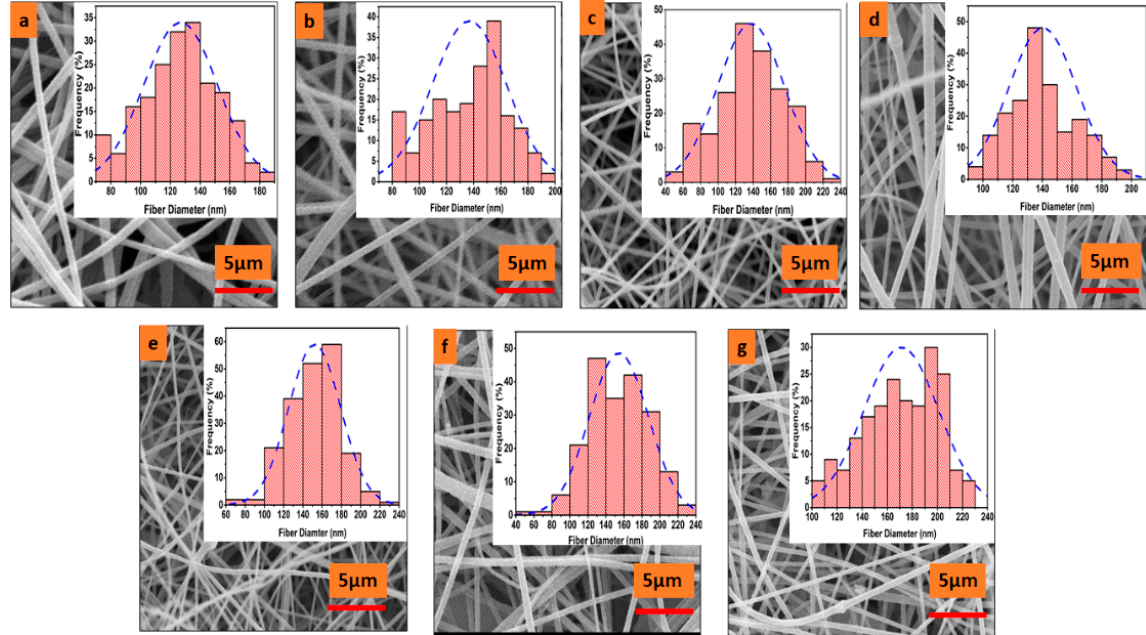
Figure 3. Surface morphology and average diameter of prepared VB-loaded ZnO/PAN electrospun nanofibers, ( a ) pristine PAN electrospun nanofibers, ( b ) ZnO/PAN electrospun nanofibers, ( c ) 0.5% VB-loaded ZnO/PAN electrospun nanofibers, ( d ) 1.5% VB-loaded ZnO/PAN electrospun nanofibers, ( e ) 2.5% VB-loaded ZnO/PAN electrospun nanofibers, ( f ) 3.5% VB-loaded ZnO/PAN electrospun nanofibers, ( g ) 5% VB-loaded ZnO/PAN electrospun nanofibers,